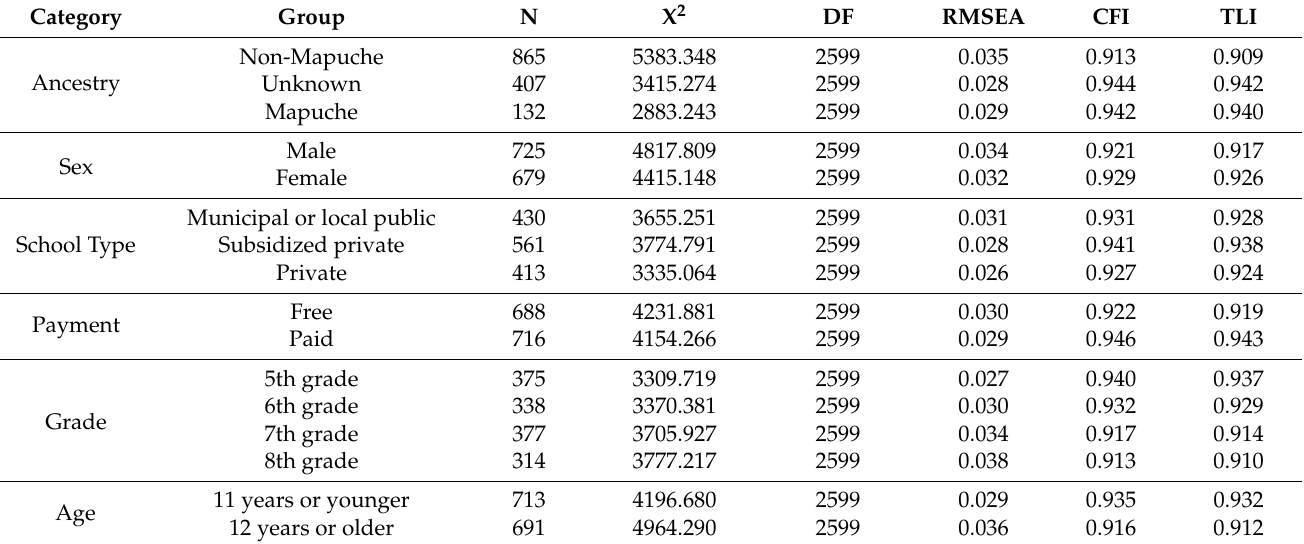
Table 9. CFA groups of the categories reviewed. Source: prepared by the authors.